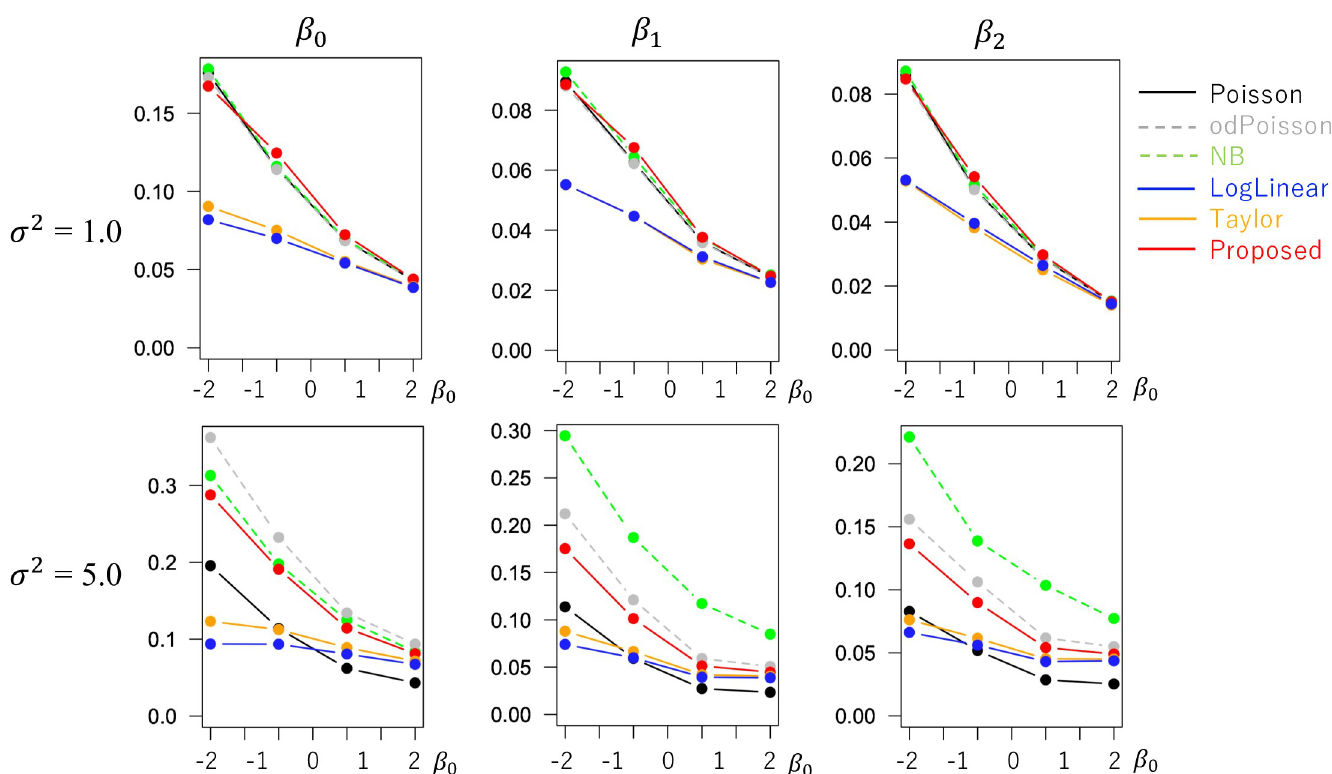
Fig 5. Means of the coefficient standard errors ( N = 200) (x − axis: β 0 , y-axis: mean standard error). https://doi.org/10.1371/journal.pone.0260836.g005 (https://cran.r-project.org/) installed in a Mac Pro (3.5 GHz, 6-Core Intel Xeon E5 processor with 64 GB memory). The gam function in the mgcv package is used for the model estimation. Under case 1 (basic model), Poisson, odPoisson, and Proposed took 20.1, 116.0, and 1.34 seconds on average, respectively. In case 2 which estimated spatial effects, Proposed is again